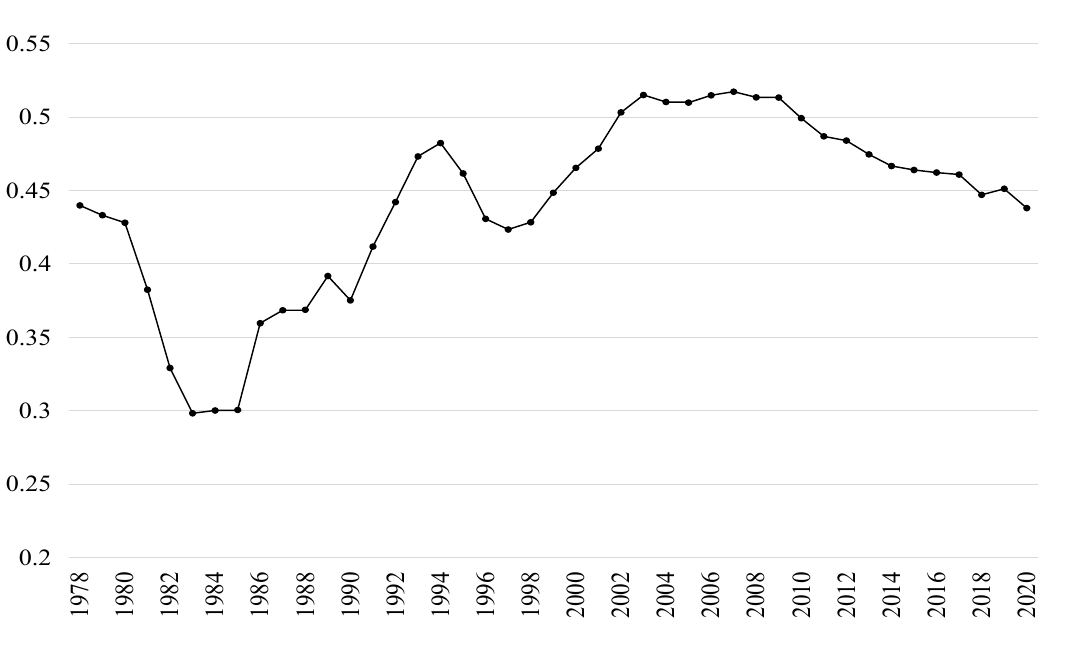
Figure 6. Income gap between urban and rural residents, 1978 to 2020. Notes: Data from China’s National Bureau of Statistics.